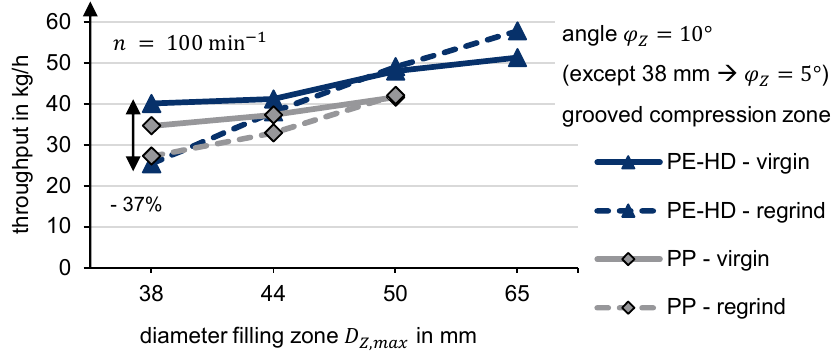
Figure 18. Experimental throughput depending on diameter extension filling zone.